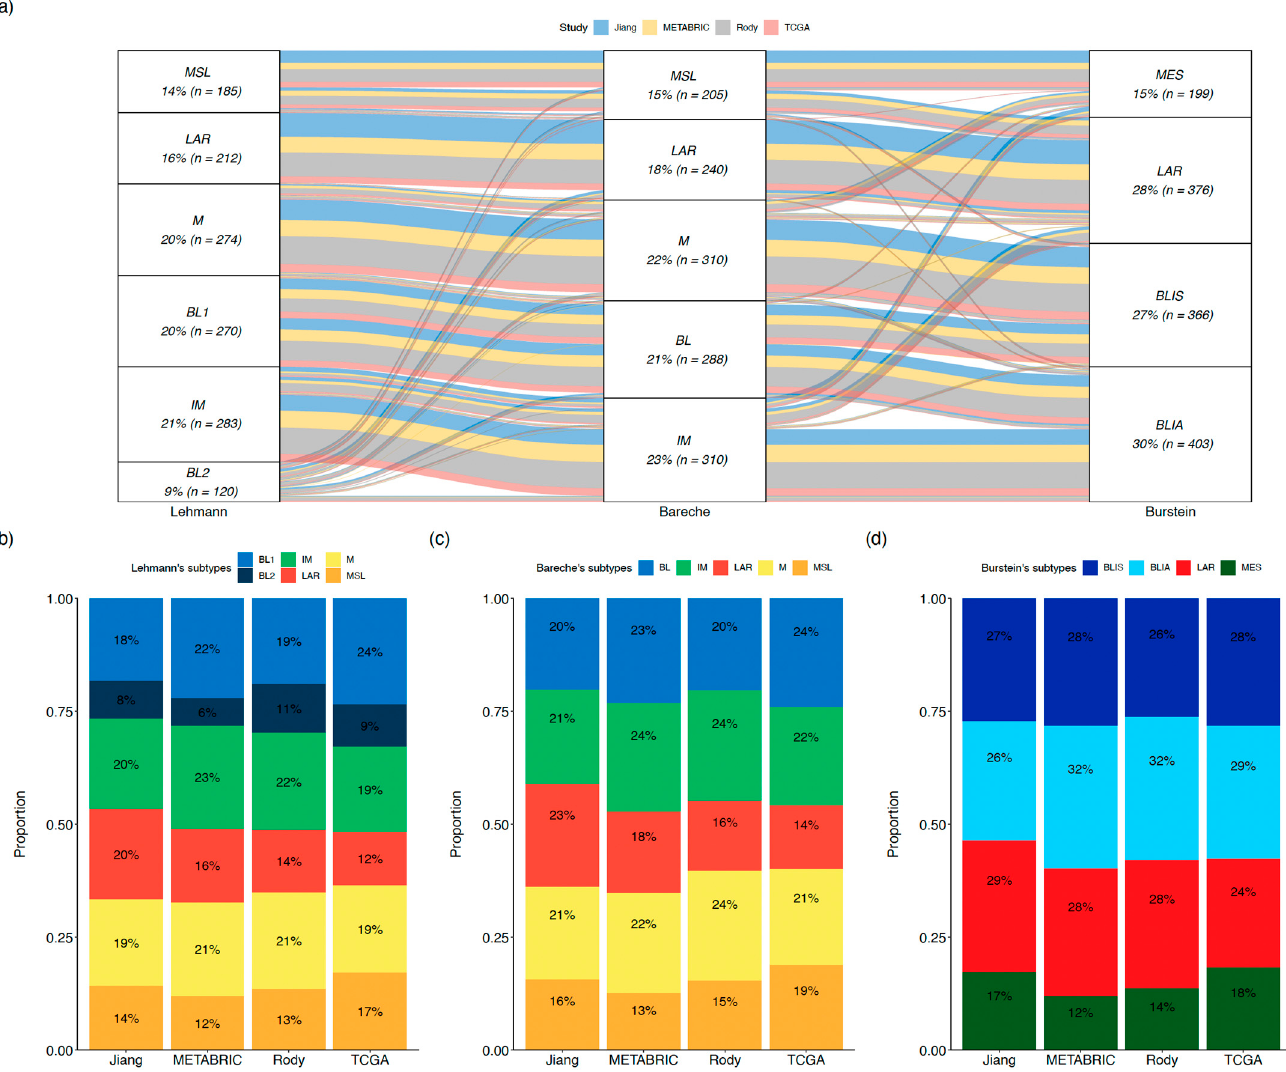
Figure 2. Lehmann’s TNBC type-6, Bareche’s, and Burstein’s molecular classifications across public datasets. ( a ) Overlap of TNBC molecular subtypes across public datasets ( b – d ). Distribution of Lehmann’s TNBC type-6, Bareche’s subtypes, and Burstein’s subtypes across each public dataset. Abbreviations. BL: basal-like, BLIA: basal-like immune-activated, BLIS: basal-like immune-suppressed, IM: immunomodulatory, LAR: luminal androgen receptor, M: mesenchymal, MES: mesenchymal, MSL: mesenchymal stem-like.